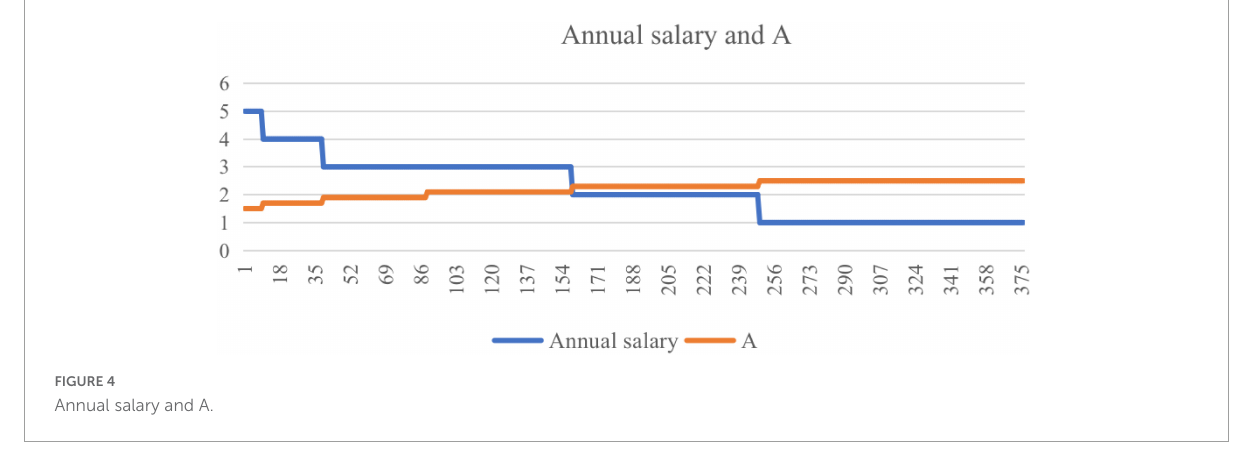
FIGURE4 Annual salary and A.